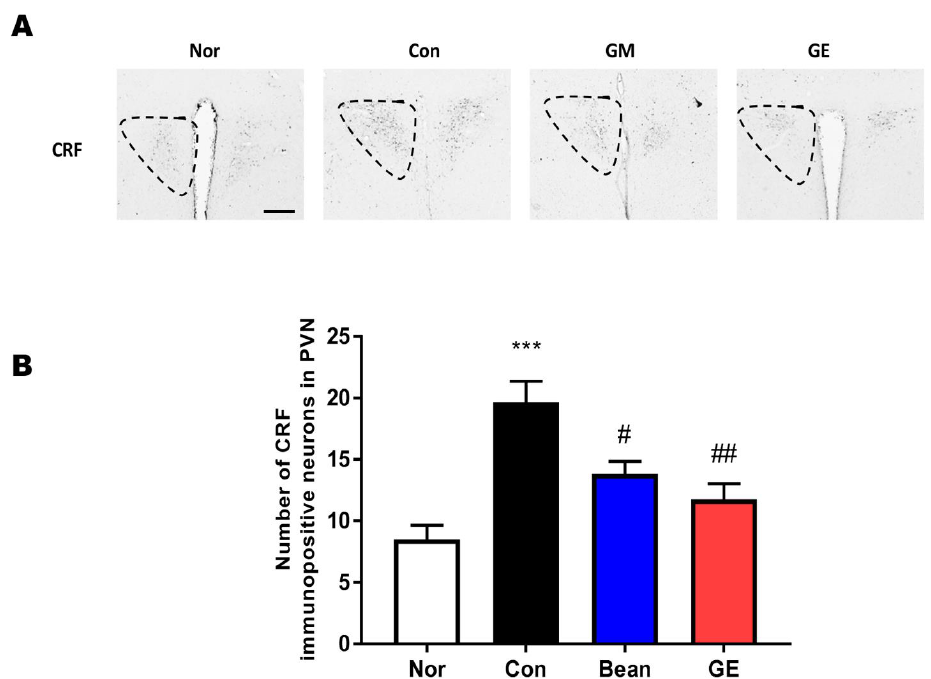
Figure 3. Effect of GM and GE on CRF neurons in the PVN. ( A ) Photomicrographs of CRF-positive cells in the PVN. ( B ) Number of CRF-positive cells in the PVN. *** p <0.001 vs. No (no stress); # p < 0.05, ## p < 0.01, vs. control (saline with EFS); one-way ANOVA followed by Tukey’s test. Normal (n = 12), control (n = 12), GM (n = 12), GE (n = 12). The scale bar represents 50 µ m.